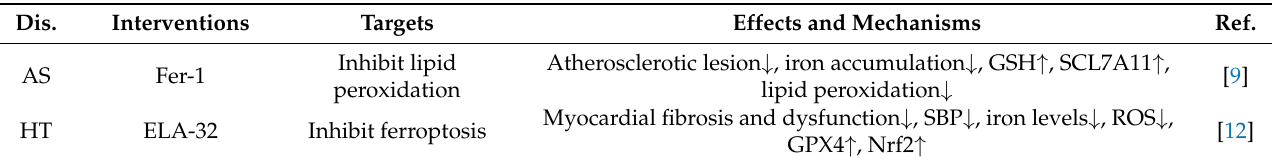
Table 3. Targeting for iron metabolism and ferroptosis in